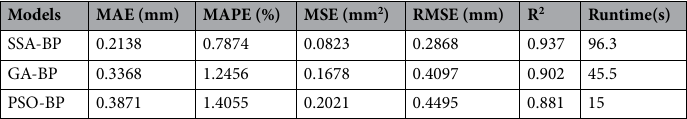
Table 11. Evaluation index value and average running time of three models at P1.